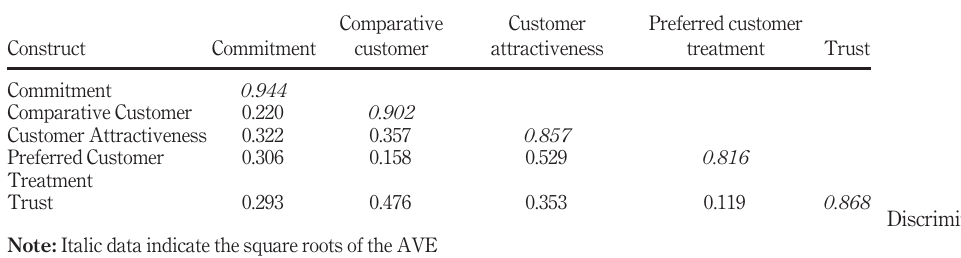
Table III. Discriminant